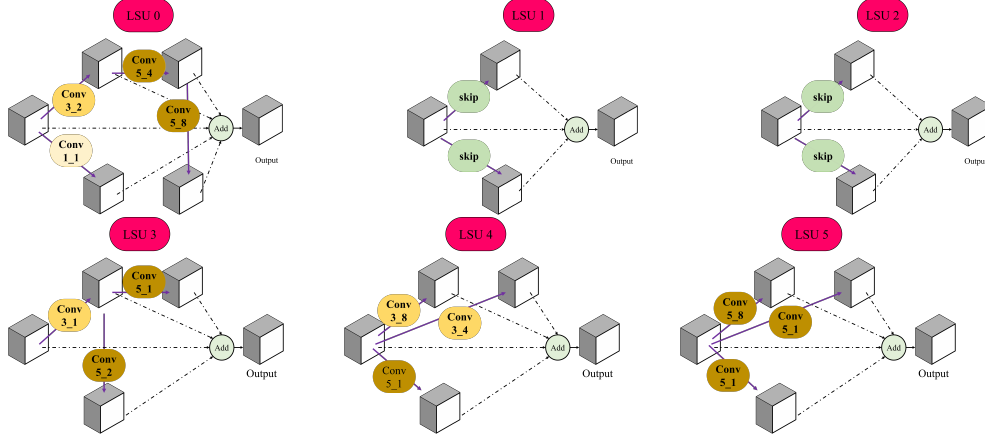
Figure 4. The LSUs in the ALSN-Large